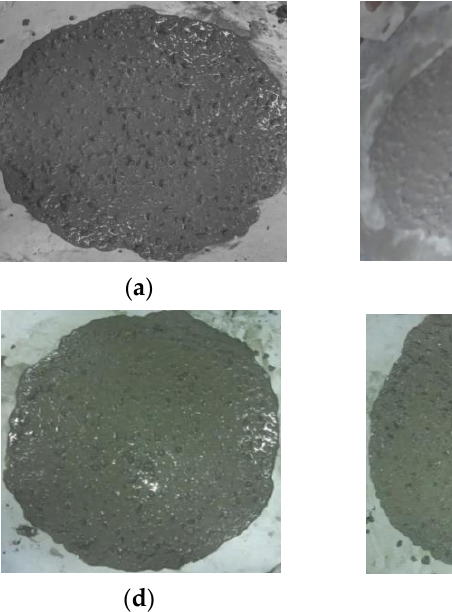
Figure 5. VSI evaluation of SSCC after adjustment. ( a ) S 0 SCC (VSI = 0, SF = 700 mm); ( b ) S 20 SCC (VSI = 0, SF = 690 mm); ( c ) S 40 SCC (VSI = 0, SF = 705 mm); ( d ) S 60 SCC (VSI = 0, SF = 710 mm); ( e ) S 80 SCC (VSI = 0, SF = 655 mm); ( f ) S 100 SCC (VSI = 0, SF = 660 mm).